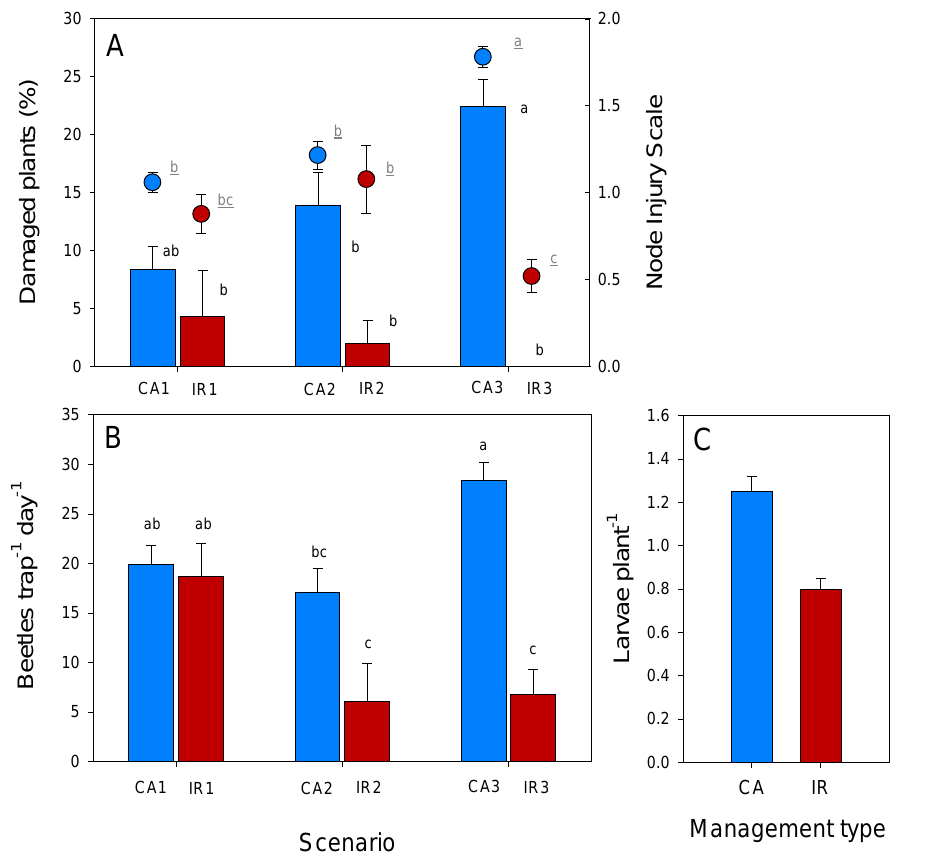
Figure 3. WCR pressure in the surveyed areas with continuous (blue) and rotated (red) maize crops: ( A ) Iowa index scores (Oleson: 0 – 3) and total (with gooseneck symptoms and lodged) damaged plants (%); ( B ) number of beetles captured by PhAM trap/day (average after six weeks), in the six scenarios under study (three areas hosting the two managements: CA, IR), years 2016–2017; ( C ) number of larvae per plant in the two managements areas: CA = chemical approach; IR = intensive rotation. Standard errors are indicated.